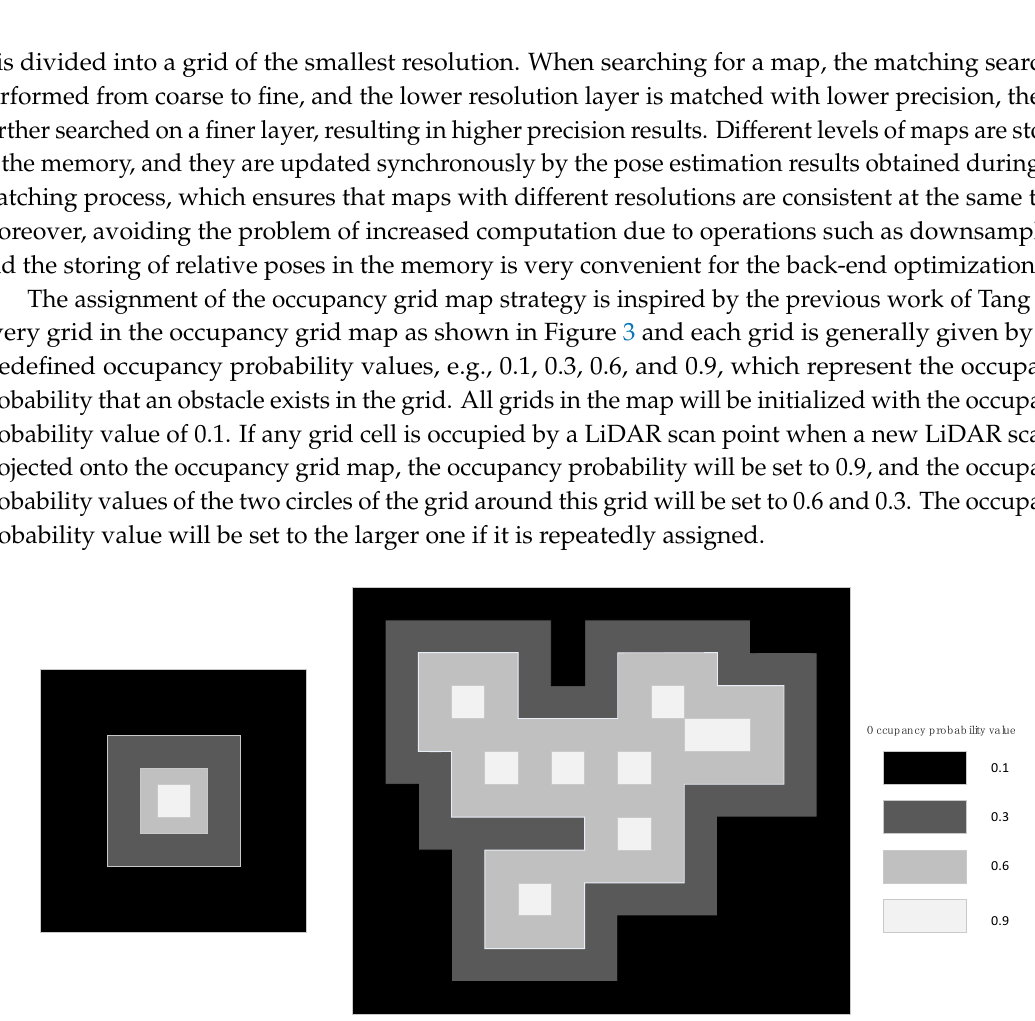
Figure 3. Probability representation of occupancy grid map.